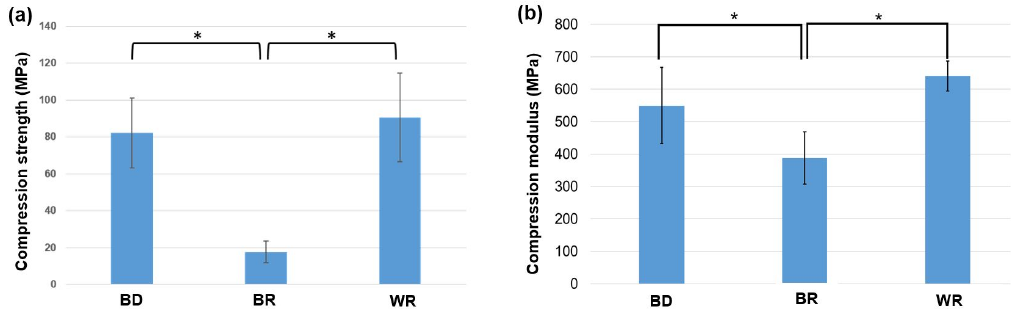
Figure 3. ( a ) Compression strength values (means and standard deviations “MPa”) and ( b ) compression modulus values (means and standard deviations “MPa”) for Biodentine™ (BD), MTA Biorep (BR), and Well-Root PT (WR). (* p < 0.05).